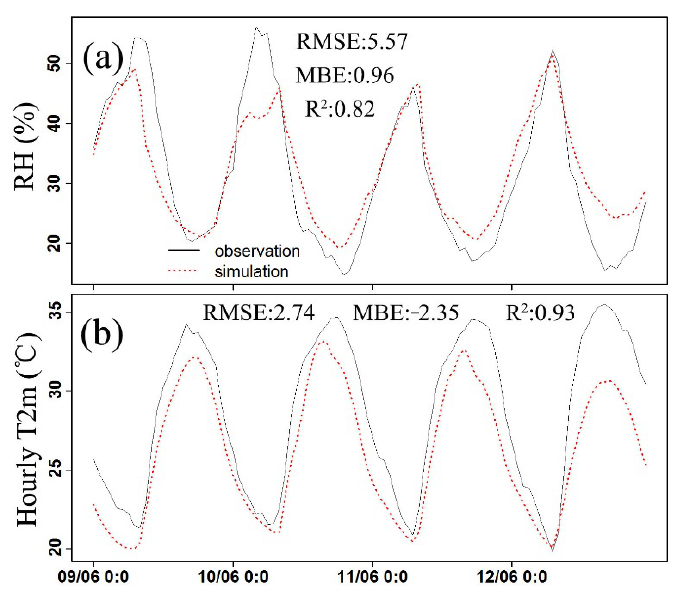
Figure 4. Comparisons of the observed and simulated (CTL) average relative humidity ( a ); 2 m temperature ( b ) over all the 5 automatic stations in the 4 clear-sky days of 9–12 June.